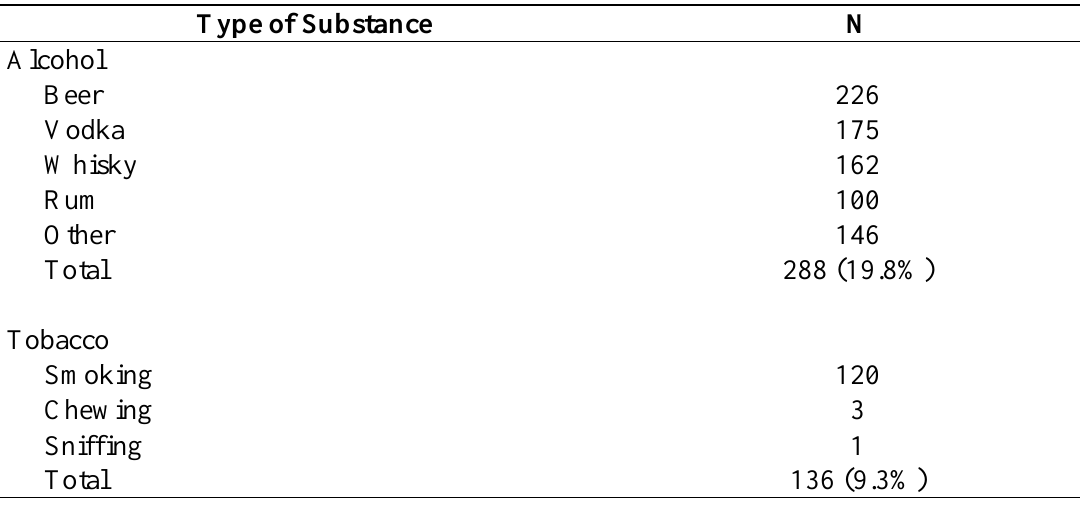
Table 4: Alcohol types and tobacco modes used for consumption Type of